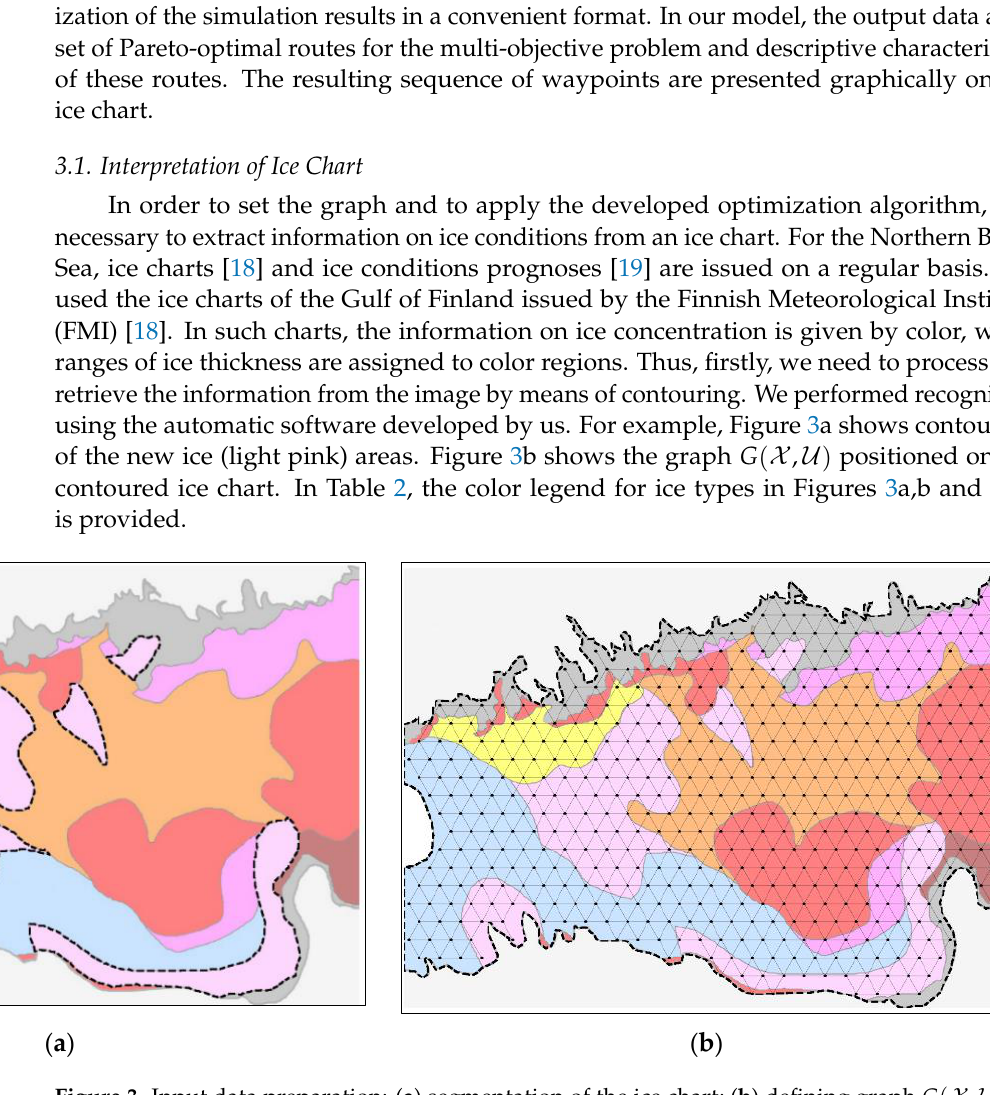
Figure 3. Input data preparation: ( a ) segmentation of the ice chart; ( b ) defining graph G ( X , U ) on the area.